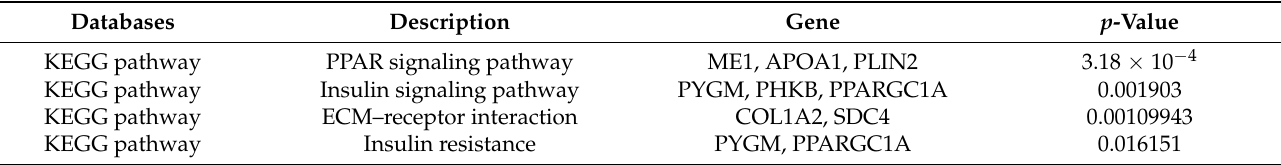
Table 10. KEGG pathways common for Bos taurus, Ovis aries , and Sus scrofa